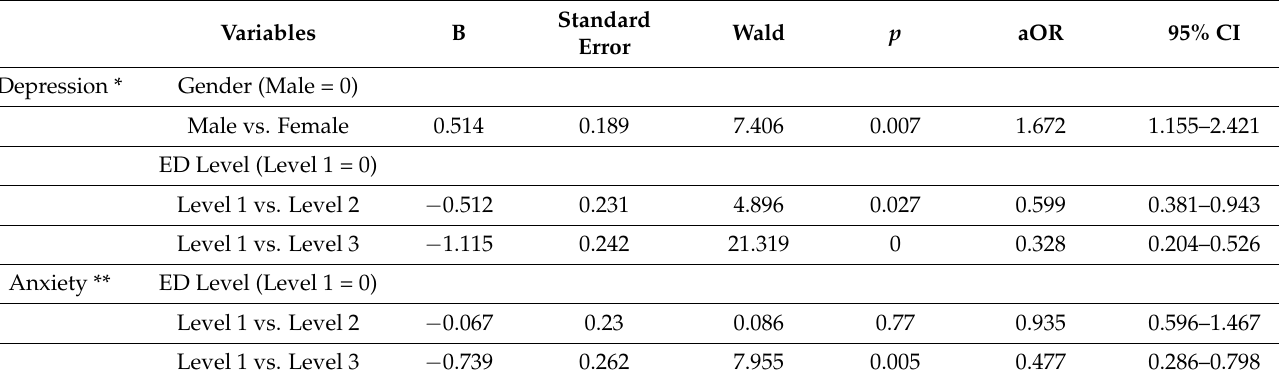
Table 5. Factors associated with depression and